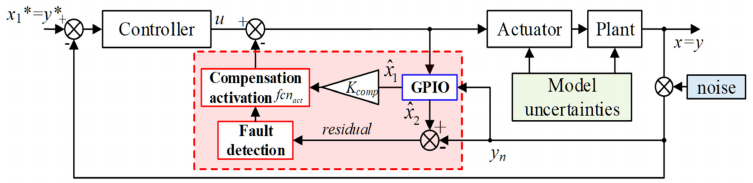
Figure 5. Diagram of GPIO-based AFTC strategy for a 2nd-order SISO close-loop system.